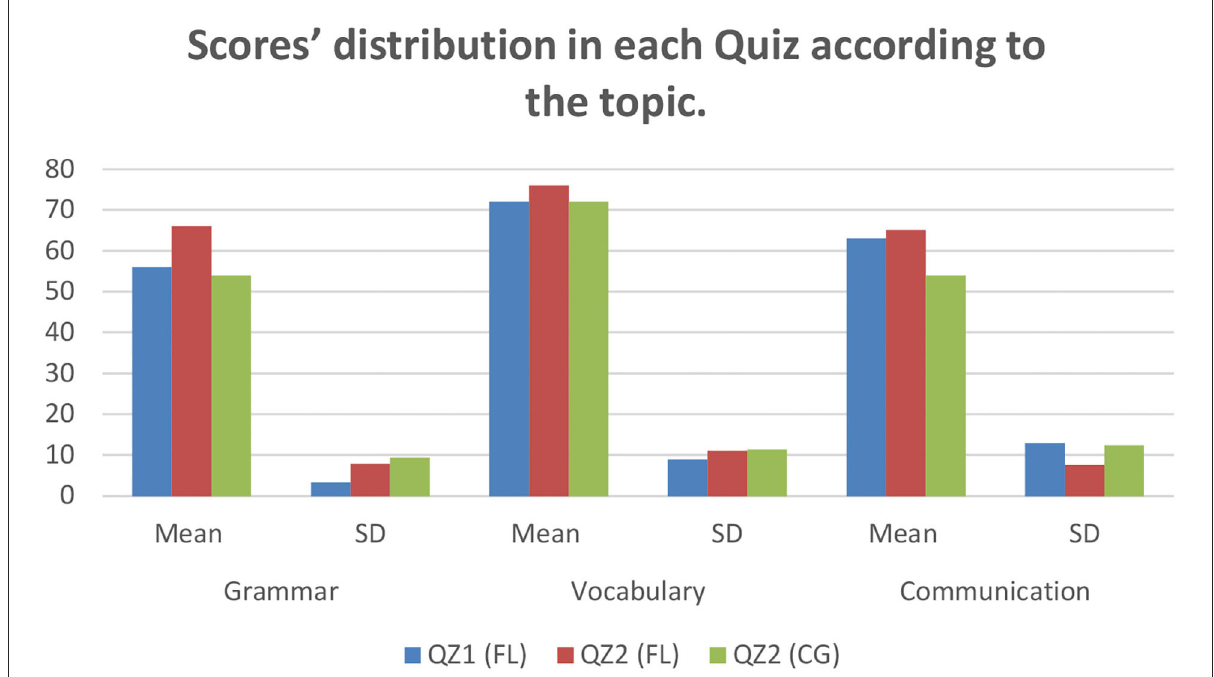
FIGURE3 Score distribution in each quiz according to the topic (QZ1, Quiz 1; QZ2, Quiz 2; FL, Flipped learning; CG, Control group).